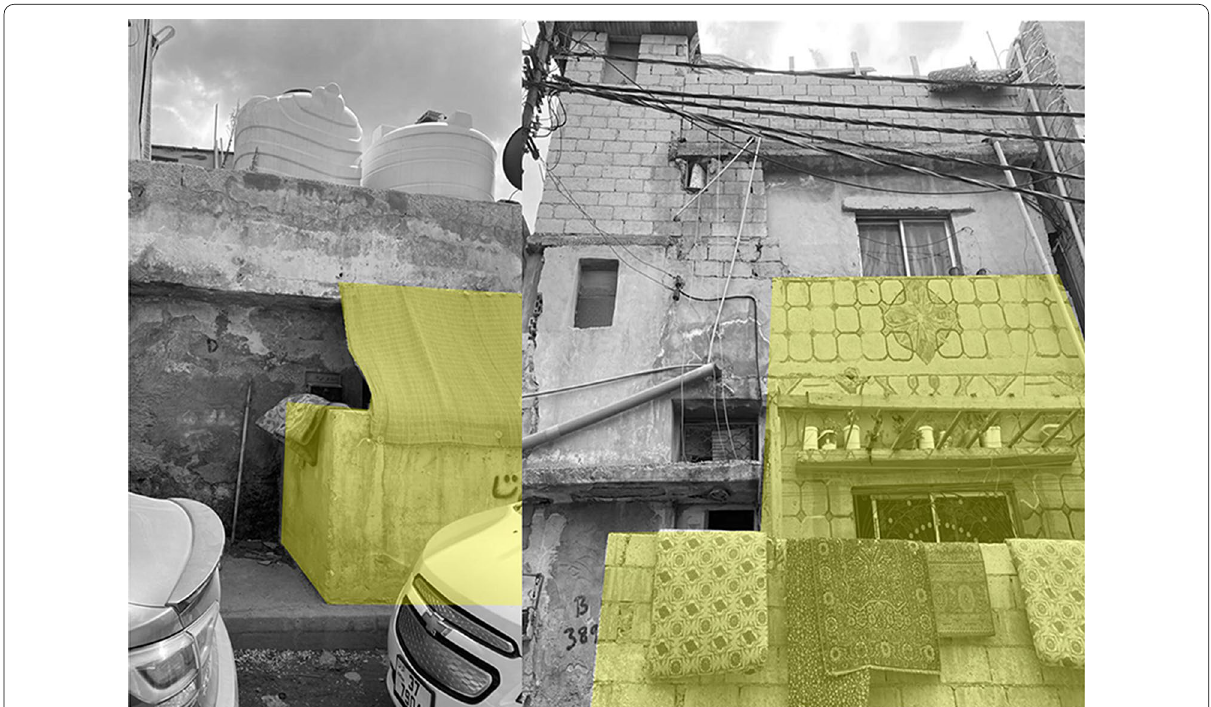
Fig. 13 Semi-outdoor private extension (photo taken by Al Baqa’a camp refugee adapted by Author